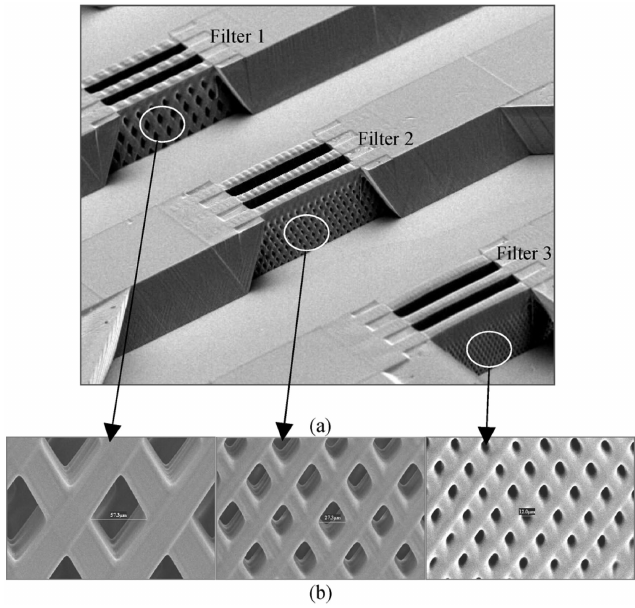
Figure 7. SEM images of ( a ) simultaneously fabricated three integrated filters in microfluidic channels with different mesh sizes and ( b ) close-up view of the ( left ) filter 1, ( middle ) filter 2 and ( right ) filter 3 which have horizontal diagonal of 57.3 μm, 27.3 μm and 10 μm, respectively. Reprinted with permission from [33], copyright 2006